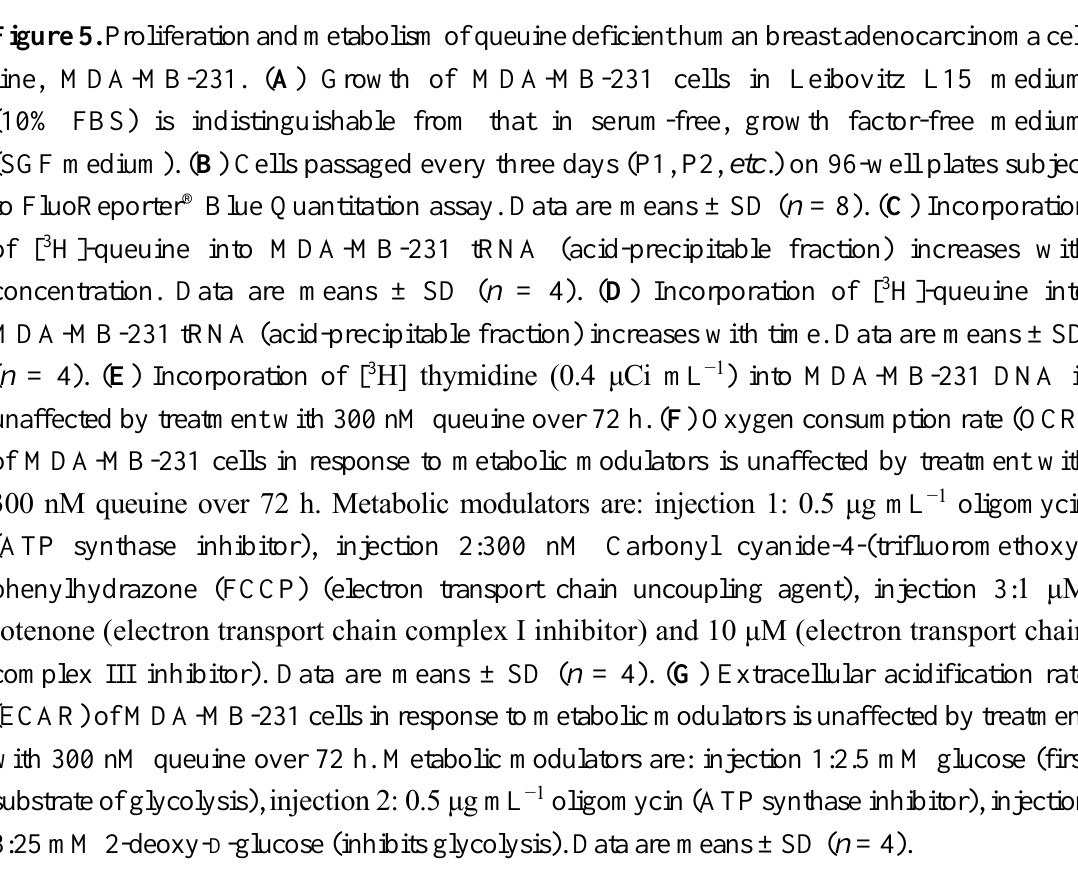
3:25 mM 2-deoxy- D -glucose (inhibits glycolysis). Data are means ± SD ( n =